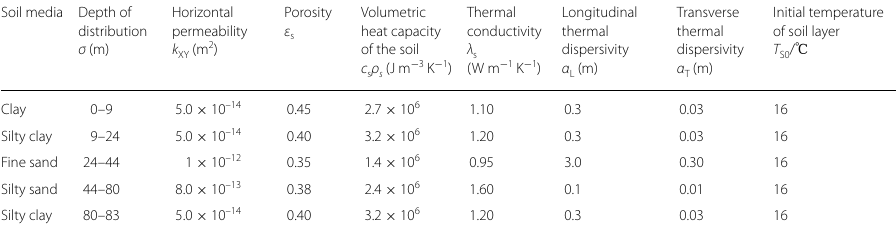
Table 1 The physical parameters of the underground rock–soil layers Soil media Depth of distribution σ